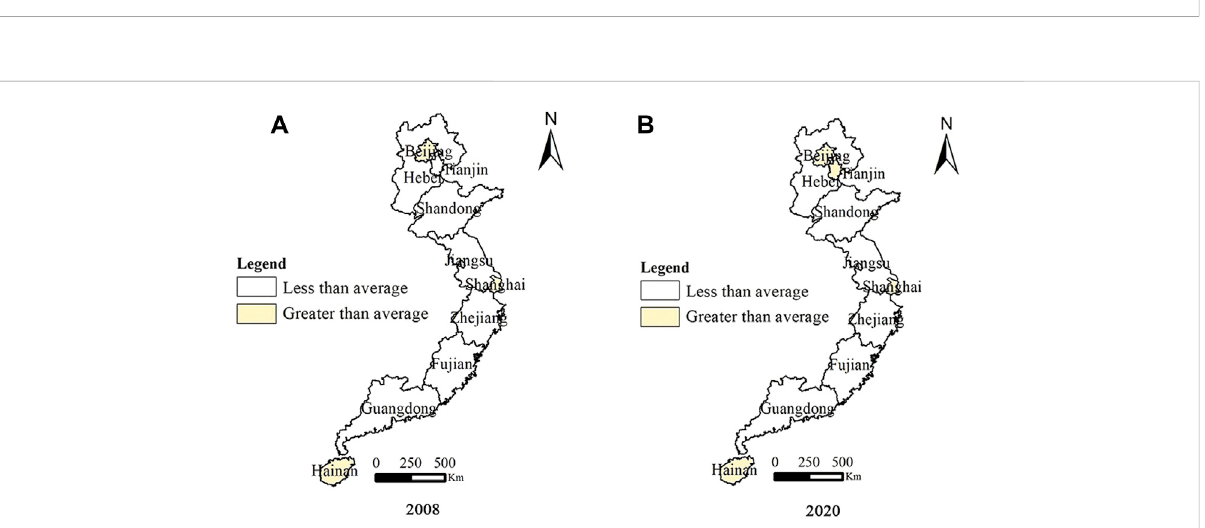
FIGURE 7 Spatial differentiation of environmental pollution control dimension (2008 and